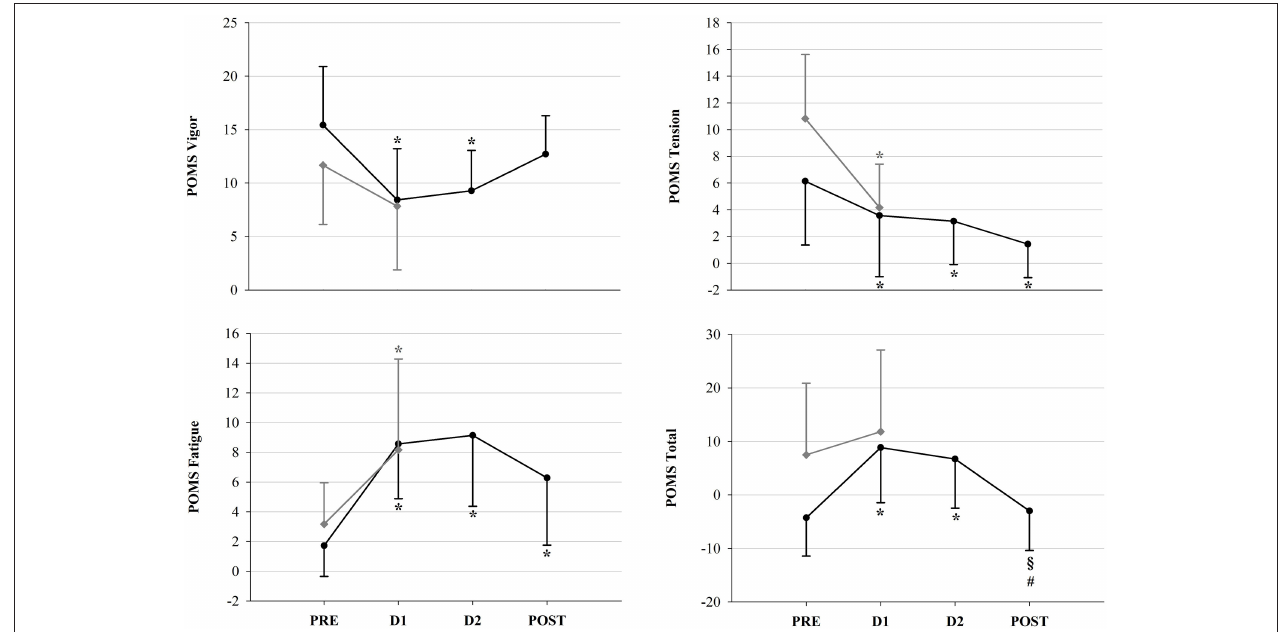
FIGURE 7 | POMS mood state scores in FIN (black line) and in NON (gray line) across time-points: * p < 0.05 vs. PRE within subgroup; § p < 0.05 vs. D1; # p < 0.05 vs. D2 (One-Way RM ANOVA).